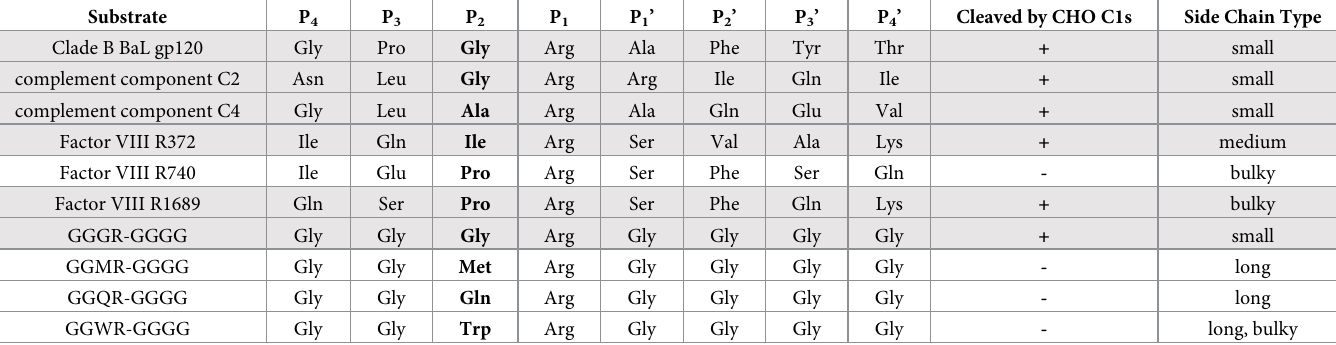
relevant substrates of C1s, C2 and C4 (Table 5). CHO C1s cleaves HIV Envs with the GPGR motif as well as the complement component C2 protein, both of which have glycine in the P2 position. CHO C1s also cleaves complement component C4 which has an alanine in the P2 position. Thus, CHO C1s efficiently cleaves substrates with a small amino acid in the P2 position. Shown are the amino acids in the P4-P4’ positions of the substrates, the susceptibility to proteolysis by CHO C1s, and a descriptor for the amino acid in the P2 position. Testing for the proteolysis of the thrombin cleavage sites on Factor VIII further revealed the nuanced substrate specificity of CHO C1s. As discussed previously, CHO C1s recognized two out of three thrombin cleavage sites, R372 and R1689, in the gp120-Factor VIII chimeric con- structs (Fig 7C). R372 has the sequence IQIR/SVAK and has an isoleucine in the P2 position. This sequence was recognized by CHO C1s due to the similarity between isoleucine and Table 5. Known substrates of CHO C1s and the substrates tested for proteolysis by CHO C1s. Substrate P